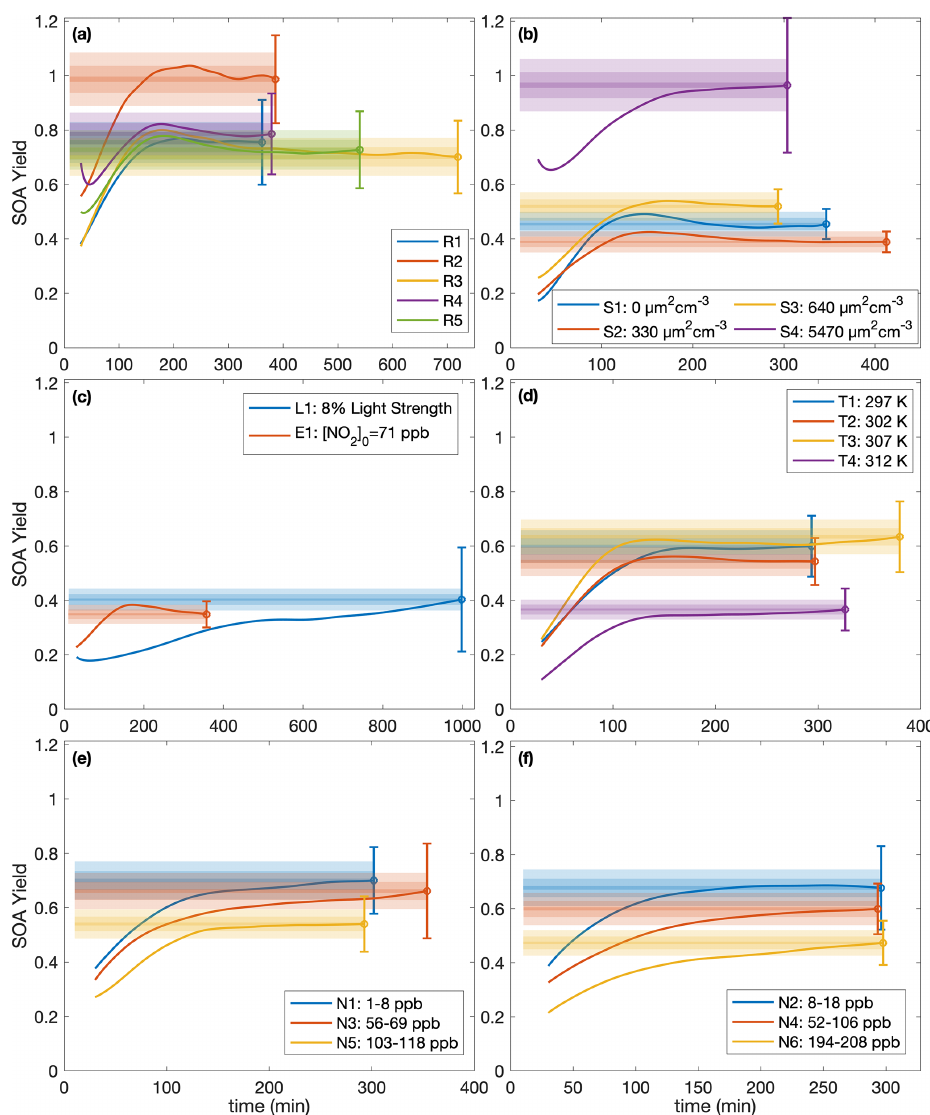
Figure 4. SOA yield calculated assuming ω = 0 as a function of time for (a) experiments run under approximately identical conditions, (b) different initial surface area experiments, (c) the low-light strength experiment (L1) and the initial NO 2 experiment (E1), (d) different temperature experiments, and (e–f) variable constant NO mixing ratio experiments. The measured SOA yields are indicated by the solid line, and the reported end yield is the circle with the reported error bars. The lightest shaded region is ± 10% of the reported end yield, the medium-shared region is ± 5%, and the darkest shaded region is ± 1%. The first 30min of oxidation are omitted due to low signal and large noise at the beginnings of the